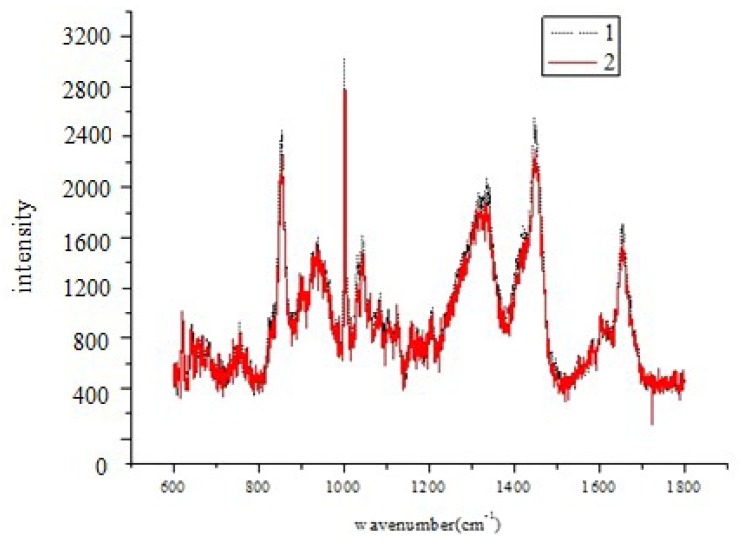
The average spectrum of spent culture media after the removal of the mineral oil layer using capillary siphoning (1) and the average spectrum of control samples (MC) (2).